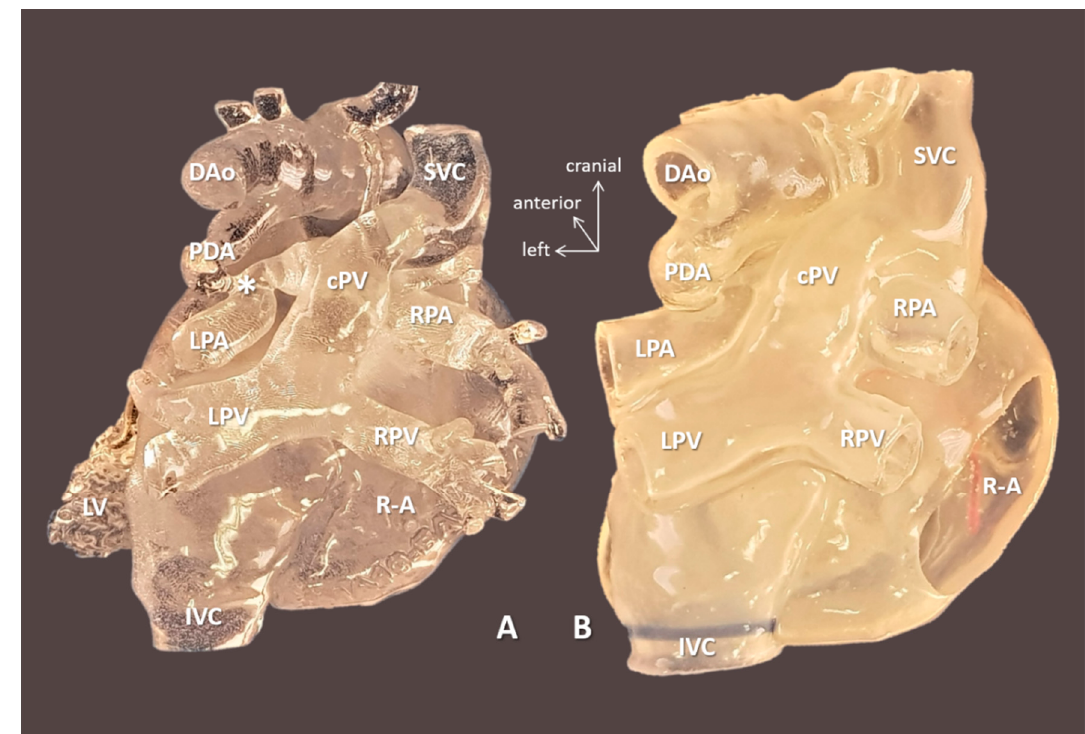
Figure 5. 3D-printed blood volume ( A ) and hollow ( B ) models of right atrial isomerism, visceral heterotaxy, and dextrocardia (Case 10). Posterior view: right-sided atrium is opened on the hollow model. Complex anomalies are illustrated on the models left-sided IVC; right-sided SVC receives inflow from common pulmonary vein (cPV), i.e., supracardiac total anomalous pulmonary venous return. Tortuous patent arterial duct (PDA) reaches the left pulmonary artery (LPA); there is pulmonary coarctation (*) at the entry point. The models were instrumental in planning for complete biventricular repair the patient successfully underwent subsequently. Abbreviations: cPV: common vertical pulmonary vein, DAo: descending aorta, IVC: left-sided inferior vena cava, LPA: left pulmonary artery, LPV: left pulmonary vein, LV: left ventricle, PDA: patent arterial duct, R-A: right-sided atrium, RPA: right pulmonary artery, RPV: right pulmonary vein, SVC: right-sided superior vena cava.